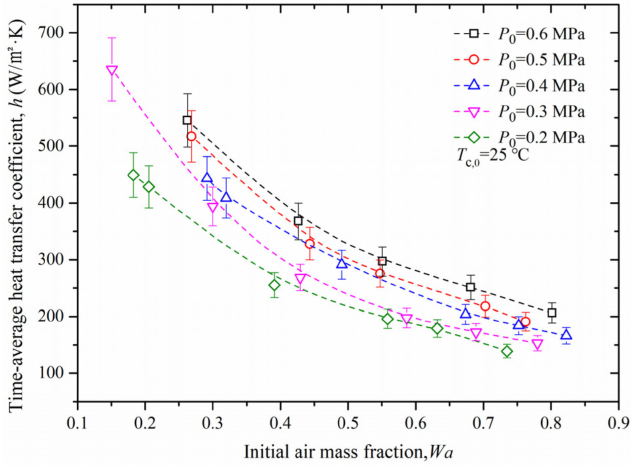
Figure 2. The variation of time-average condensation HTC with initial air mass